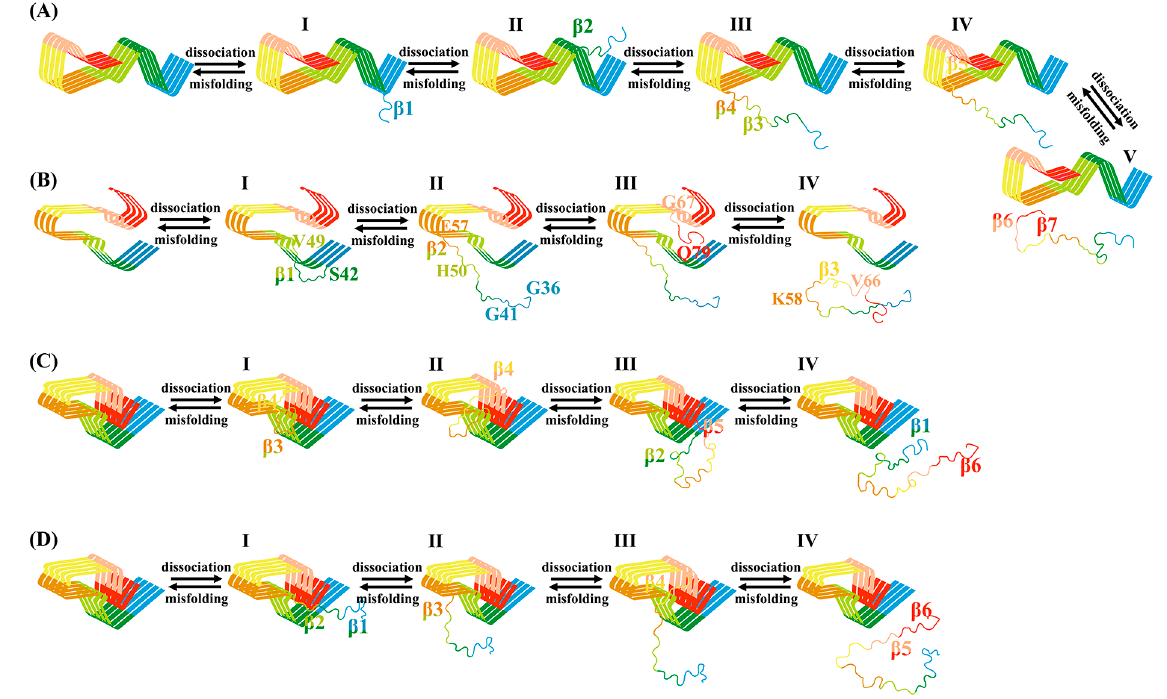
Figure 7. Schematic representation of the dissociation mechanism of the boundary chain and the deduced misfolding mechanism of α -Syn monomer in the induction of three different templates. ( A ) human brain system; ( B ) cofactor-tau system; ( C ) cofactor-free system in path1; ( D ) cofactor-free system in path2.